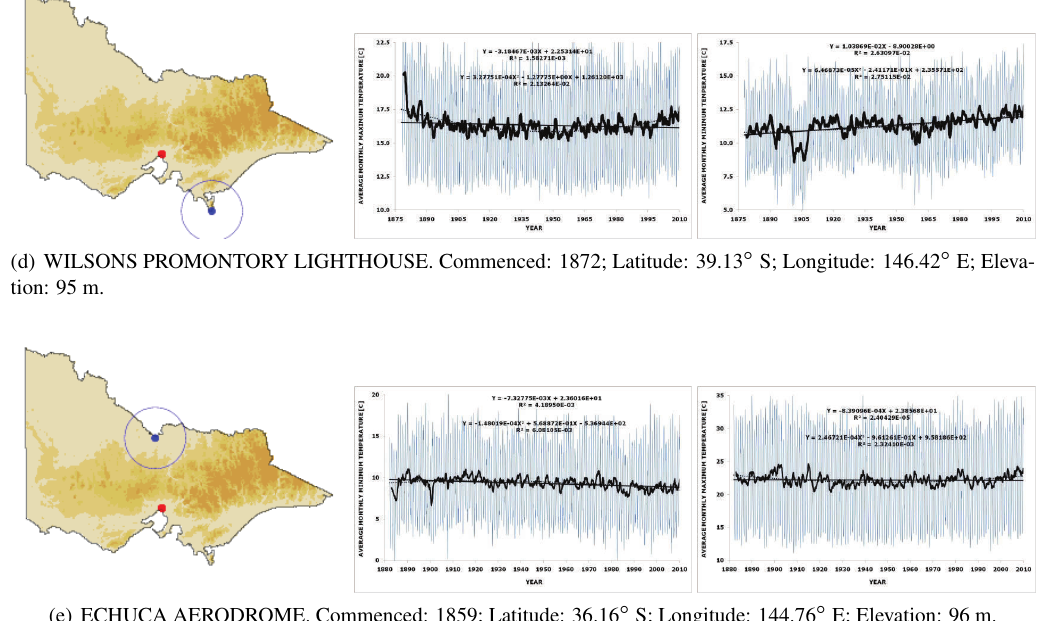
Figure 2. Last 100-150 years raw data for monthly mean maximum and minimum temperatures for selected historical measuring stations in Victoria, Australia. 12 months moving averages and linear and second order polynomial trend lines applied to the monthly average